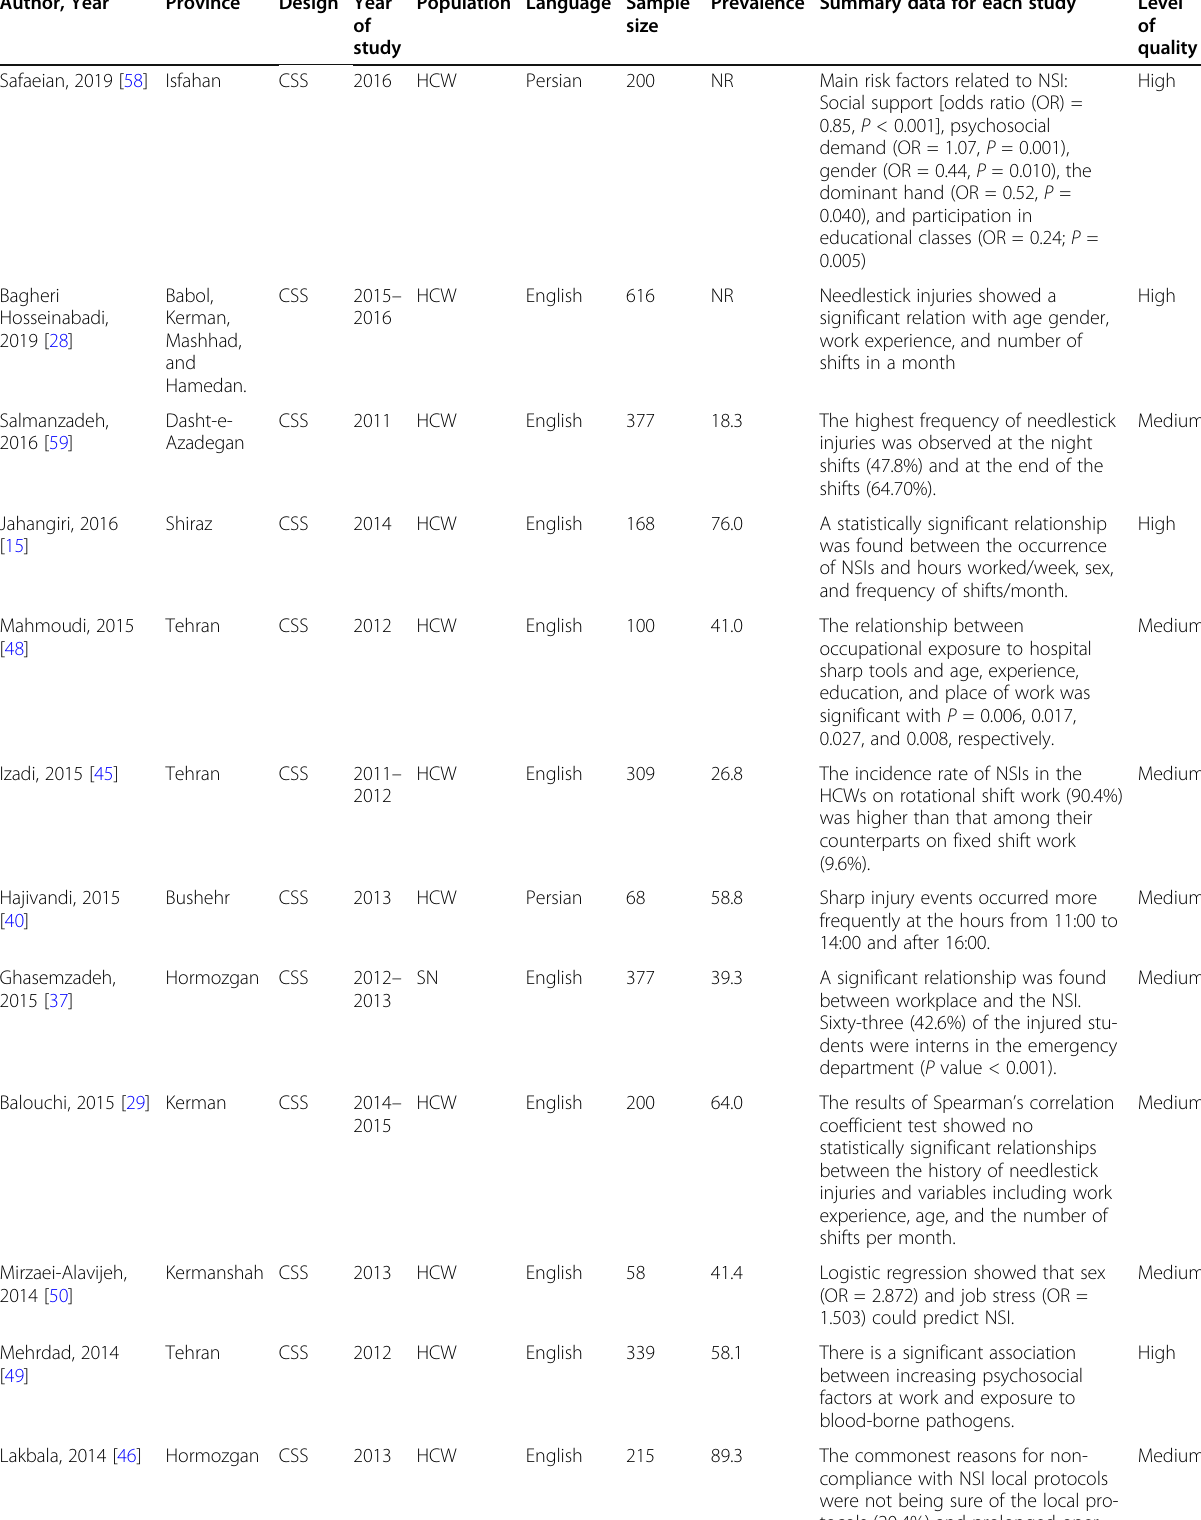
Table 1 Descriptive data of included